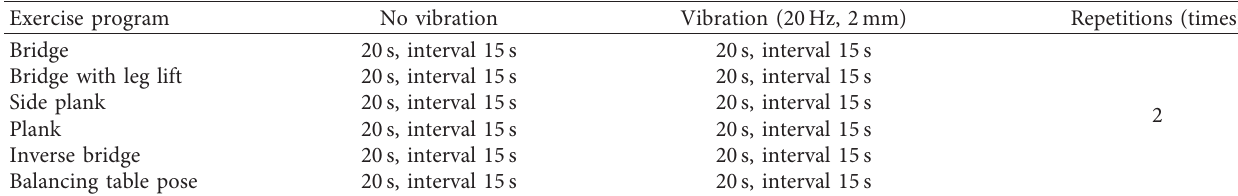
Table 1: Parameters and intensity of whole-body vibration exercise in WBV